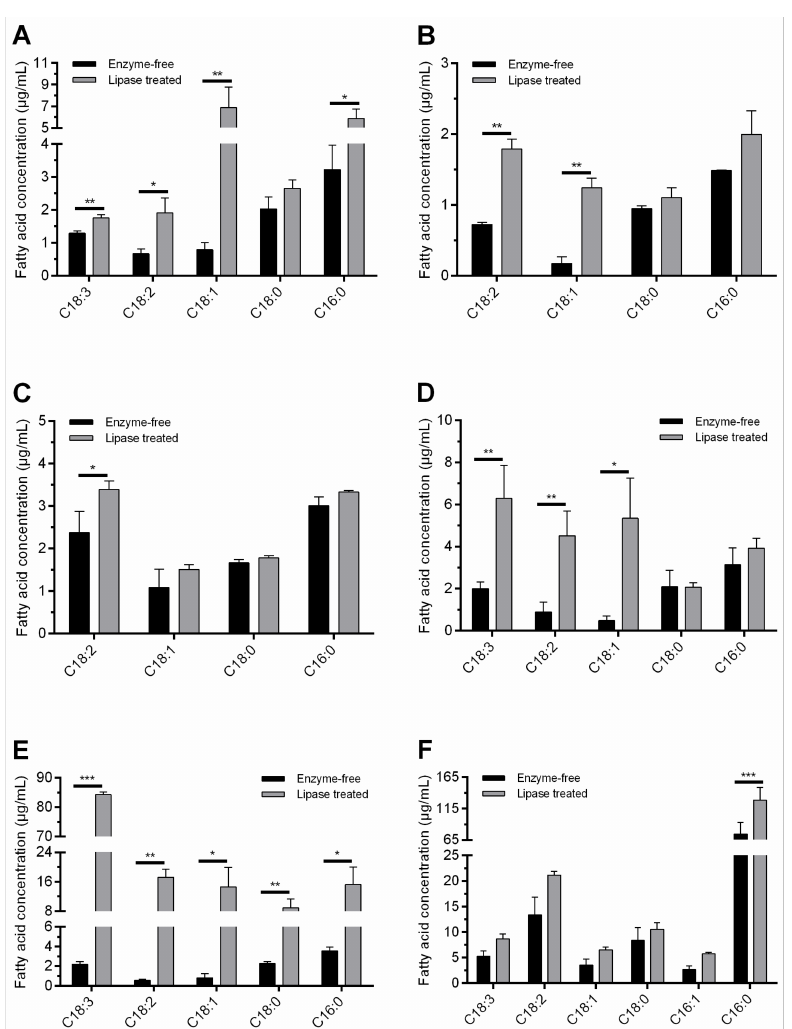
Figure 1. Concentration of major free fatty acids ( µ g/mL reaction mixture) determined by GC-MS in enzyme-free and R. miehei lipase treated olive ( A ), almond ( B ), peanut ( C ), rapeseed ( D ), linseed ( E ) and grape seed ( F ) vegetable oil substances. Lipolytic reactions were performed at 40 ◦ C for 24 h. Fatty acids: α -linolenic acid, C18:3; linoleic acid, C18:2; oleic acid, C18:1; stearic acid, C18:0; palmitoleic acid, C16:1; palmitic acid, C16:0. Results presented are averages of concentration values determined in three replicates; error bars represent standard deviations. Asterisks indicate significant differences between the enzyme-free and treated samples according to multiple t-tests performed by GraphPad Prism version 7.00, FDR (Q = 10%), * p < 0.05, ** p < 0.01, *** p <